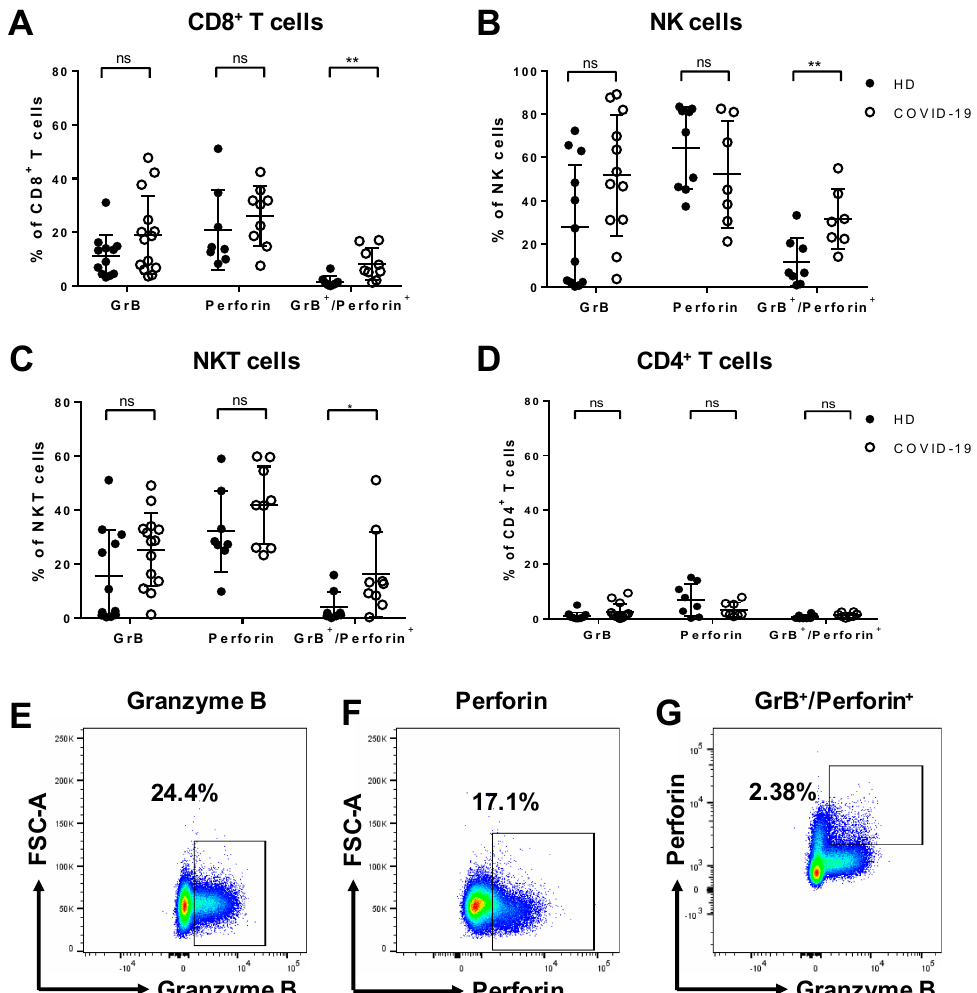
Figure 1. Secretion of granzyme B (GrB) and perforin by di ff erent leukocyte populations in COVID-19. Peripheral blood mononuclear cells (PBMCs) of COVID-19 patients and healthy donors (HD) were stimulated ex vivo with phorbol myristate acetate (PMA) / ionomycin for 5 h to analyze the frequency of cytokine-producing cells by flow cytometry. In COVID-19 patients, the frequency of cells co-expressing GrB and perforin was significantly increased among CD8 + T cells ( A ) NK cells ( B ), and NKT cells ( C ). The frequency of CD4 + T cells secreting GrB or perforin was unaltered upon stimulation ( D ). Representative fluorescence-activated cell sorting (FACS) plots of GrB ( E ), perforin ( F ), and GrB + / perforin + ( G ) secretion by CD8 + T cells in COVID-19 patients. Data are shown as mean ± SD. 3.3. Expression of CD39 and CD73 by Lymphocyte Subsets from COVID-19 Patients and Healthy Controls